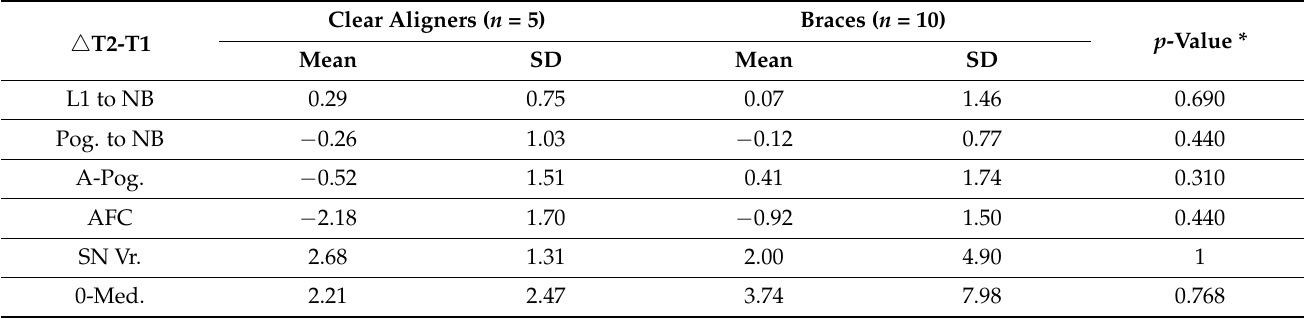
Table 3. Postoperative stability measurement between the clear aligner group and the traditional fixed appliance (e.g., bracket) group on the 2nd day and 6th month postoperatively. (cid:52)